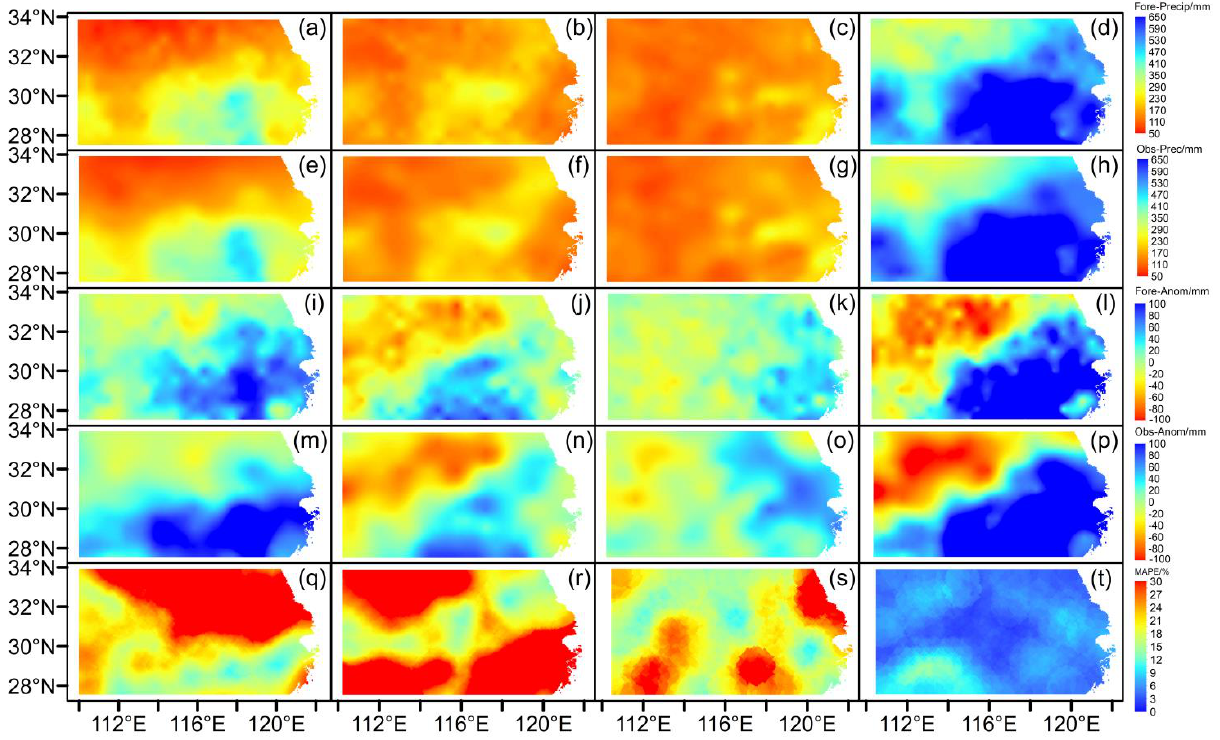
Figure 9. Spatial distributions of the “best” summer precipitation forecasts using January factors by GABP over the test periods [i.e., eight-month (summer) means over 2012–2019], where the first and second rows indicate forecasted precipitations with absolute values and corresponding observations, respectively (e.g., ( a – d ) are for forecasted June, July, August and summer precipitations, respectively, with ( e – h ) corresponding to the observations, respectively); the third and fourth rows are the same as the first and second rows, respectively, but for anomalies; the fifth row represents MAPE distributions; the columns from left to right show results for June, July, August and summer, respectively.